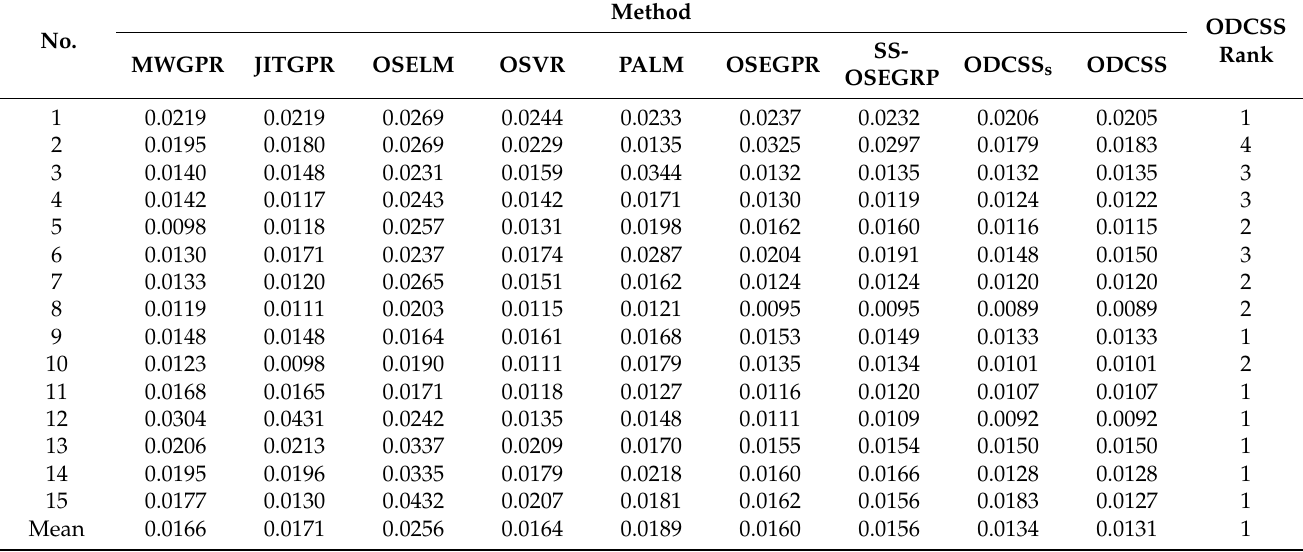
Table 5. The prediction RMSE values of different soft sensor methods on the test subsets in TE process.